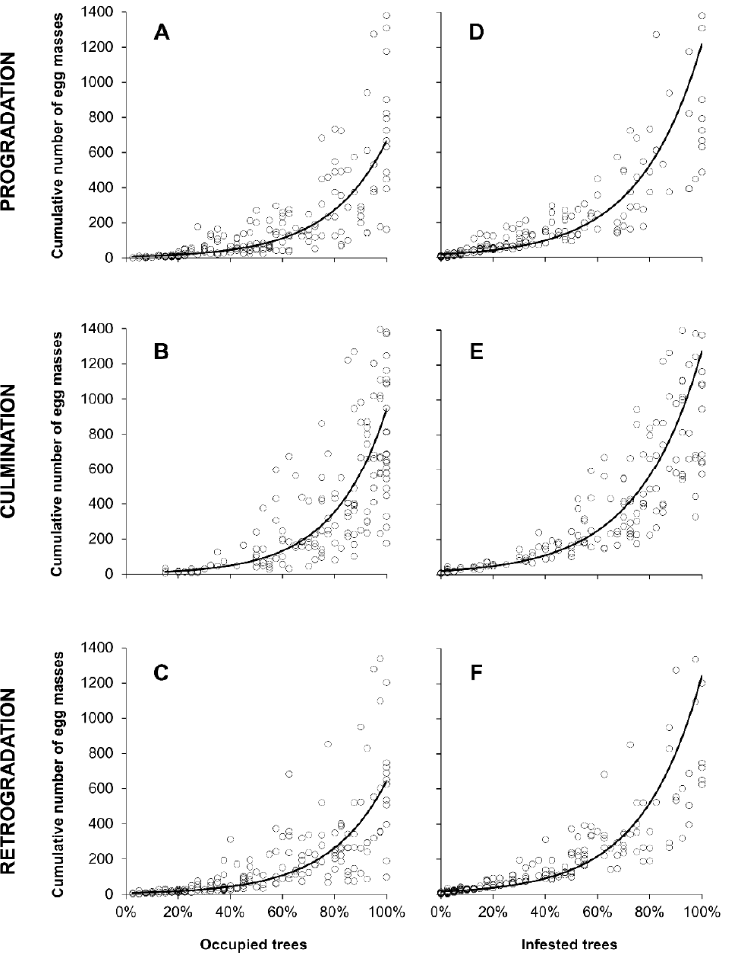
Figure 3. Relationship between the cumulative number of Lymantria dispar egg masses and the per- centage of occupied (with one or more egg masses) and infested (with three or more egg masses) trees. Linear regressions were fitted separately for each phase of gypsy moth population develop- ment: progradation ( A , D ), culmination ( B , E ), retrogradation ( C , F